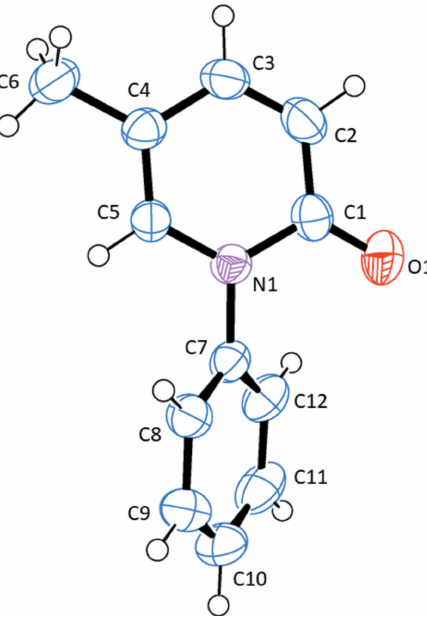
Figure 1 A view of the molecular structure of pirfenidone with the atom labelling. Displacement ellipsoids are drawn at the 50% probability